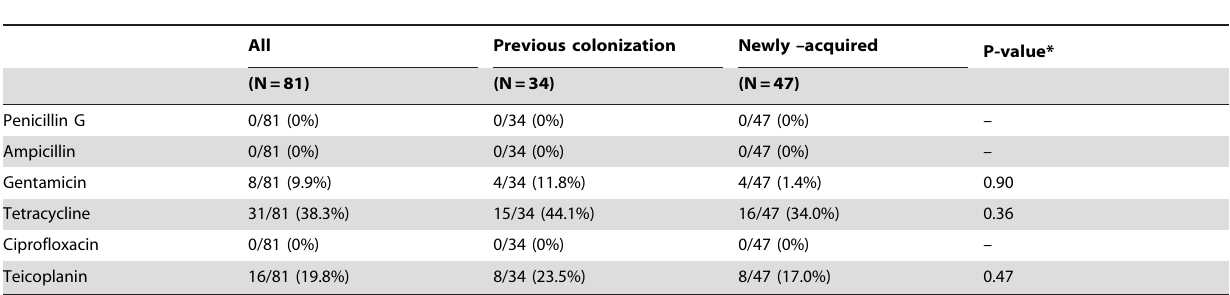
Table 4. Drug susceptibility tests among patients with previous colonization and newly acquired VRE.